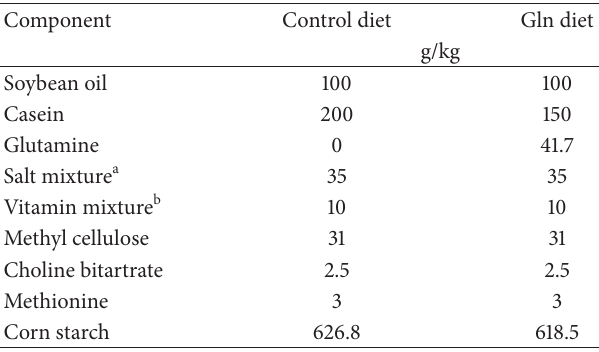
Table 1: Composition of the semipurified diets.